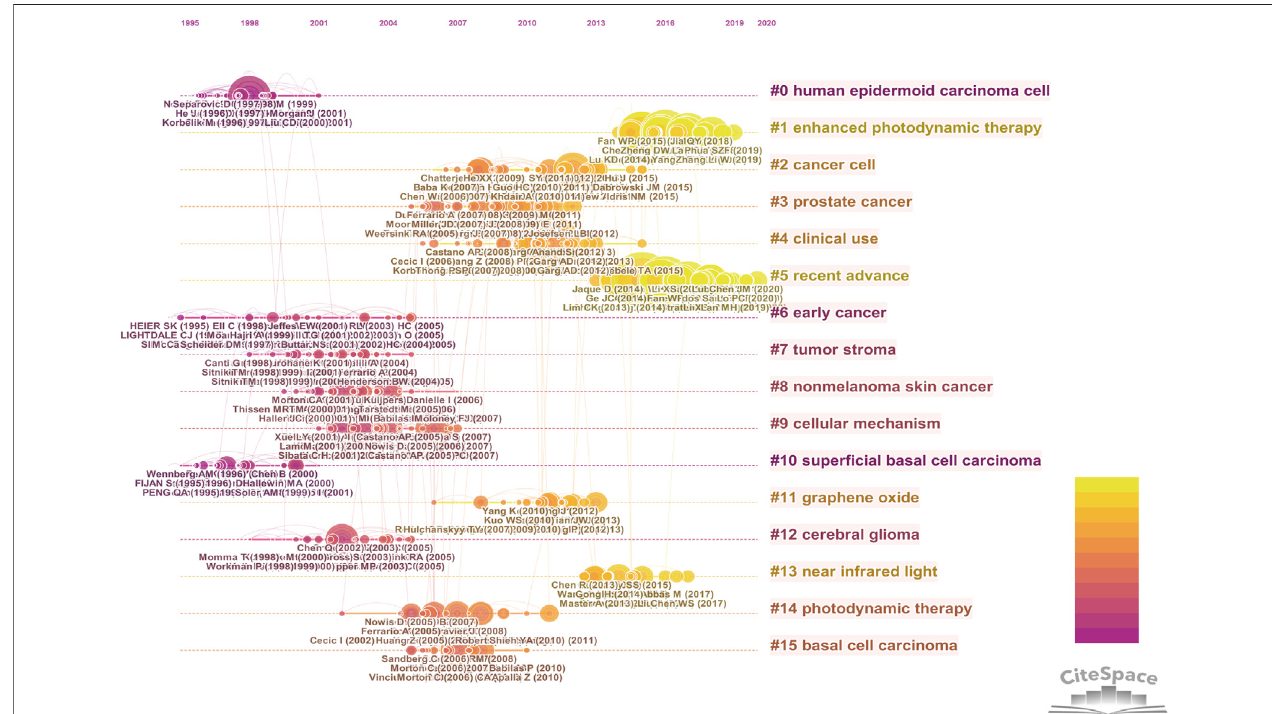
FIGURE9| Referenceco-citation analysisbyCiteSpace.Inthistimelineviewmap,thepositionofthenode onthehorizontalaxisindicatesthetimepoint ofthe fi rst appearance,andlinesconnectingthenodesrepresentco-citedrelationships.Thenode ’ ssizeisproportionaltothenumberofcitationsofthereference.Themoreyellow the color means closer to 2021, while the redder the color means closer to